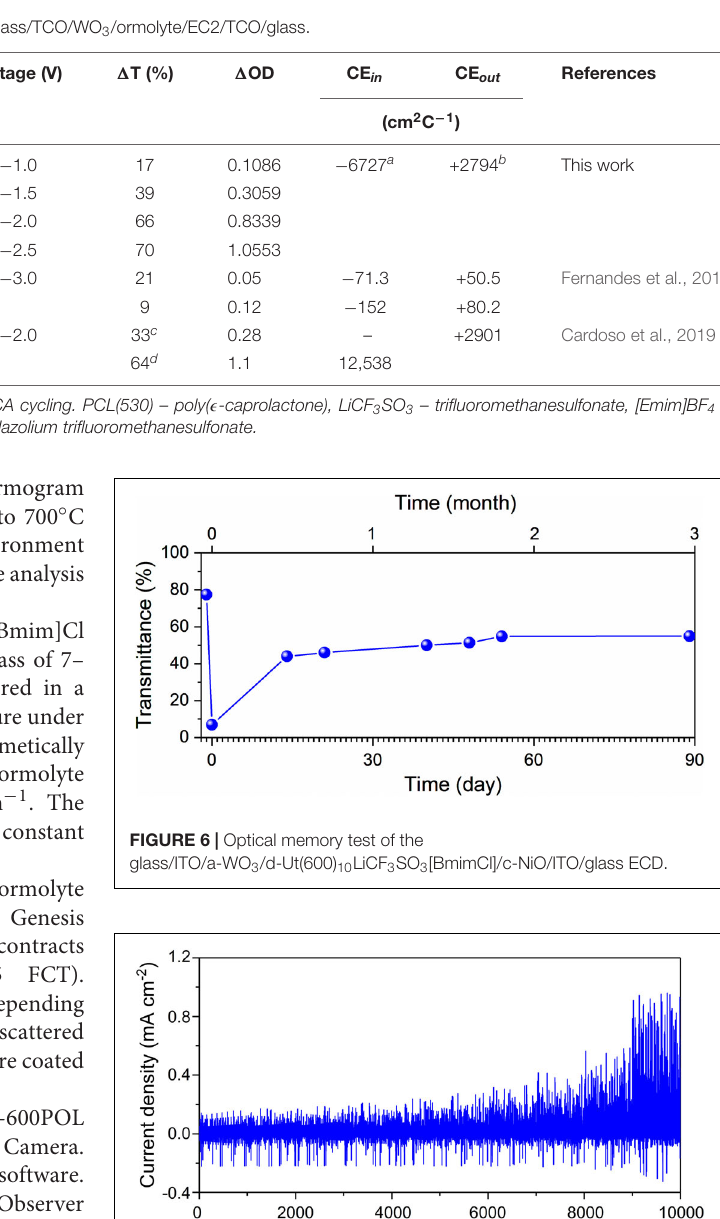
values were measured at five different spots. At each spot five measurements were performed. The results reported